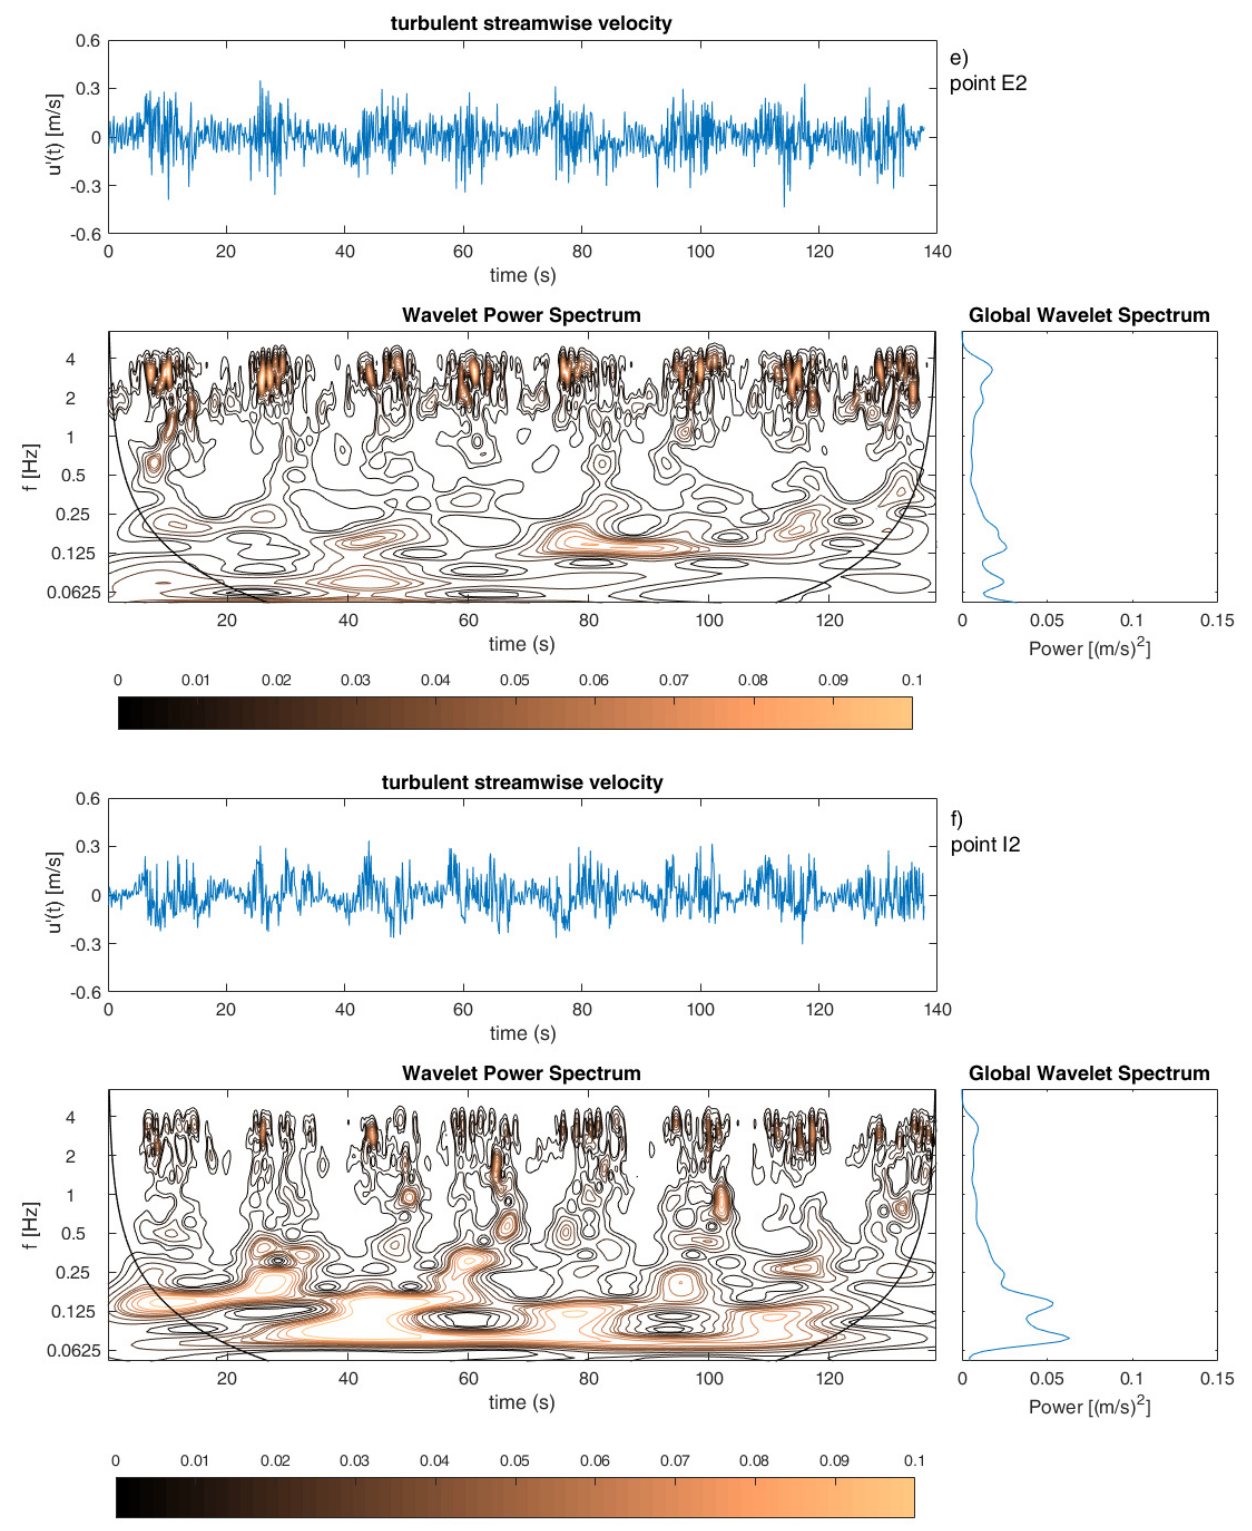
Figure 7. W2 wave: signal of the turbulent streamwise velocity u’ ( t ), spectrogram of u’ ( t ), and global wavelet spectrum for the selected points: O1 ( a ), E1 ( b ), I1 ( c ), O2 ( d ), E2 ( e ), and I2 ( f ). Considering points O1 and O2 (Figure 7a,d) in the wavelet power spectrum low in- The results of the wavelet power spectrum for points E1 and E2 along the edge tensities are generally observed, except than in the range of frequencies (0.0625 ÷ 0.25 s − 1 ) (Figure 7b,e) are also remarkable. Moreover, in this case, high intensities in the wavelet spectrum occur at frequencies (0.0625 ÷ 0.25 s − 1 ), manifesting again the presence of